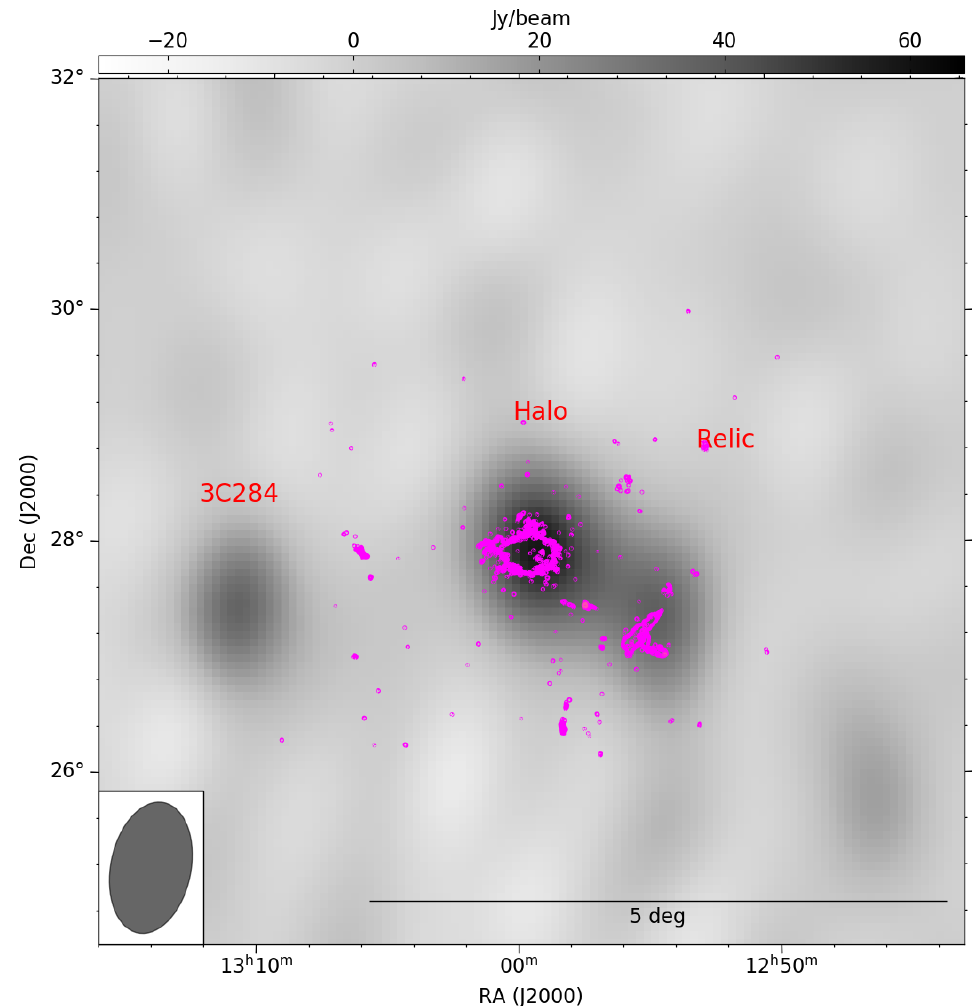
Figure 4. Intrinsic flux image of the Coma cluster. Green corresponds to negative flux values, i.e., artefacts and confusion noise. The noise is 3.5 Jy beam − 1 , and the pink contours correspond to an overlay of the 144 MHz LOFAR image of Coma shown in Figure 1 of Bonafede et al. [5], starting at 5 σ . The integrated flux density of the Coma cluster itself (halo and point sources) is 81.5 ± 15 Jy. The restoring beam size is shown in the bottom